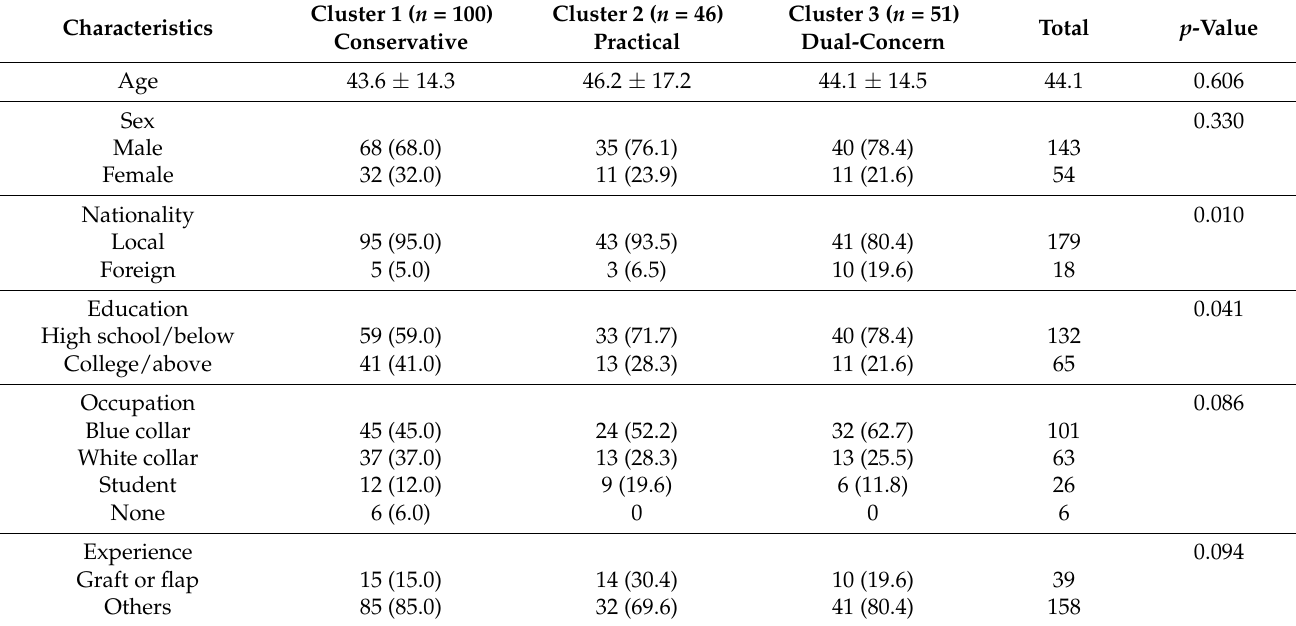
Figure 5. ( a ) Mean utility and patient numbers of the three clusters. The radar plot reveals a striking pattern of differences between clusters. For example, cluster 1 shows a strong preference for less risk compared to other clusters. ( b ) The importance score per cluster. Table 4. Cluster analysis with the sociodemographic profiles of the